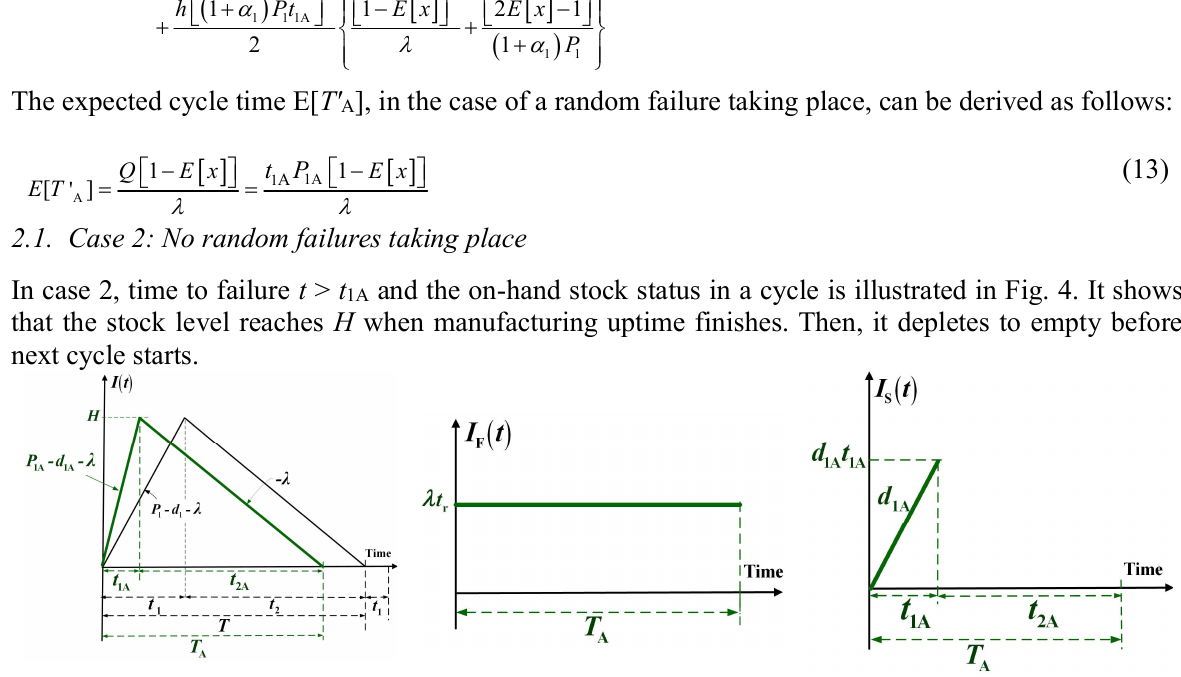
Fig. 5 . The on-hand status of safety stocks in the proposed system with scrap and an expedited rate, but without failures taking place